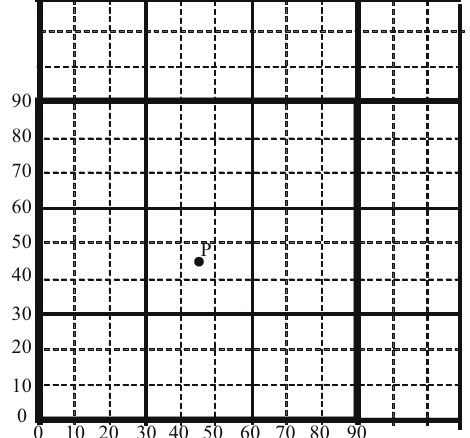
Fig. 3. Point (P) is the common centre point where all 10, 30 and 90 (m) cell resolutions are overlapping in a